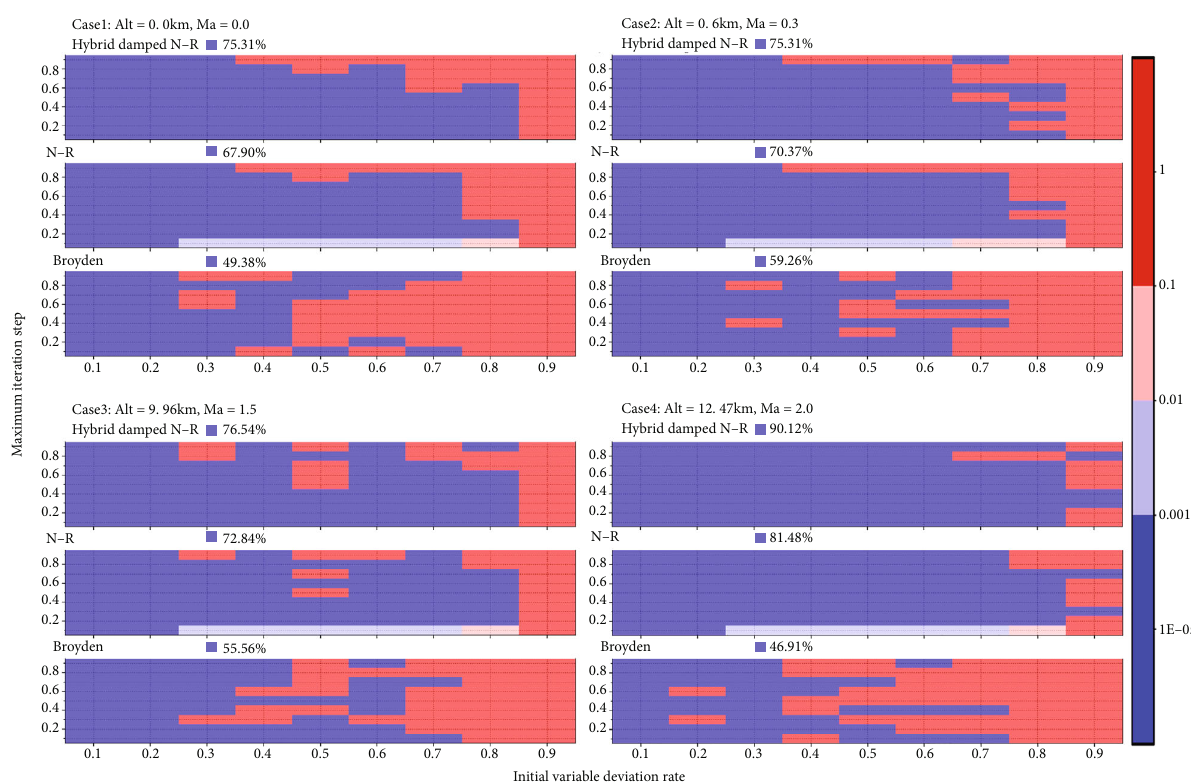
Figure 7: Hotspot diagram for convergence analysis of di ff erent iterative algorithms.